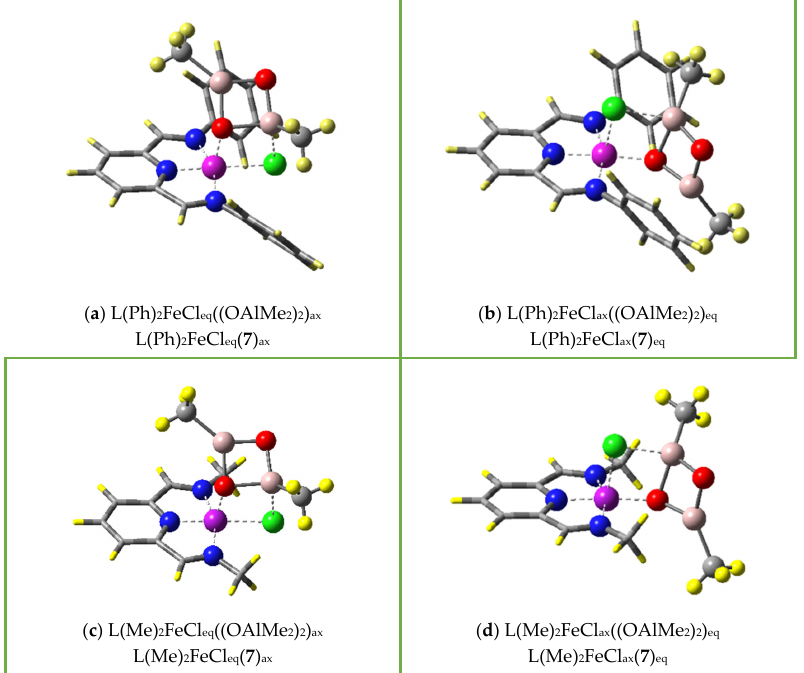
Figure 5. Computed structure of catalyst with 7 , (OAlMe 2 ) 2 , a small cyclic aluminoxane. Top row: N , N -diphenyl ligand L; bottom row: N , N -dimethyl ligand L. Left column: equatorial chloride; right column: axial chloride.